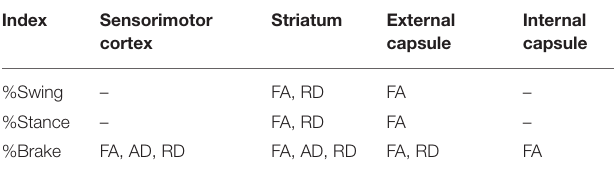
TABLE 1 | The summary of significant correlations between the gait and DTI